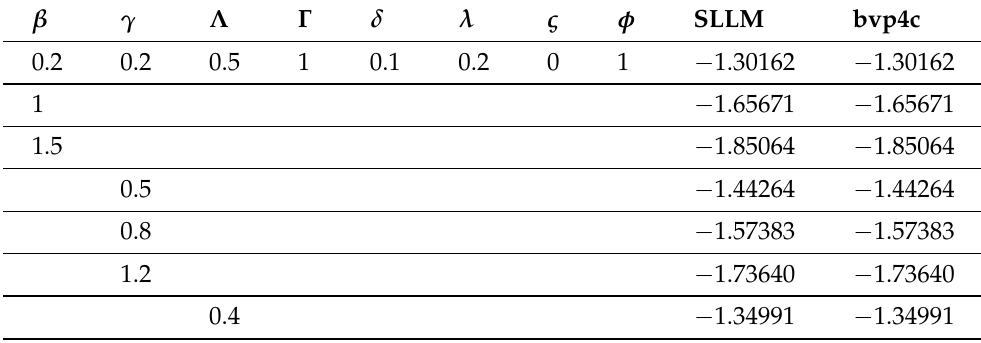
Table 4. Numerical comparison between the present numerical method and bvp4c for Skin friction against different values of emerging